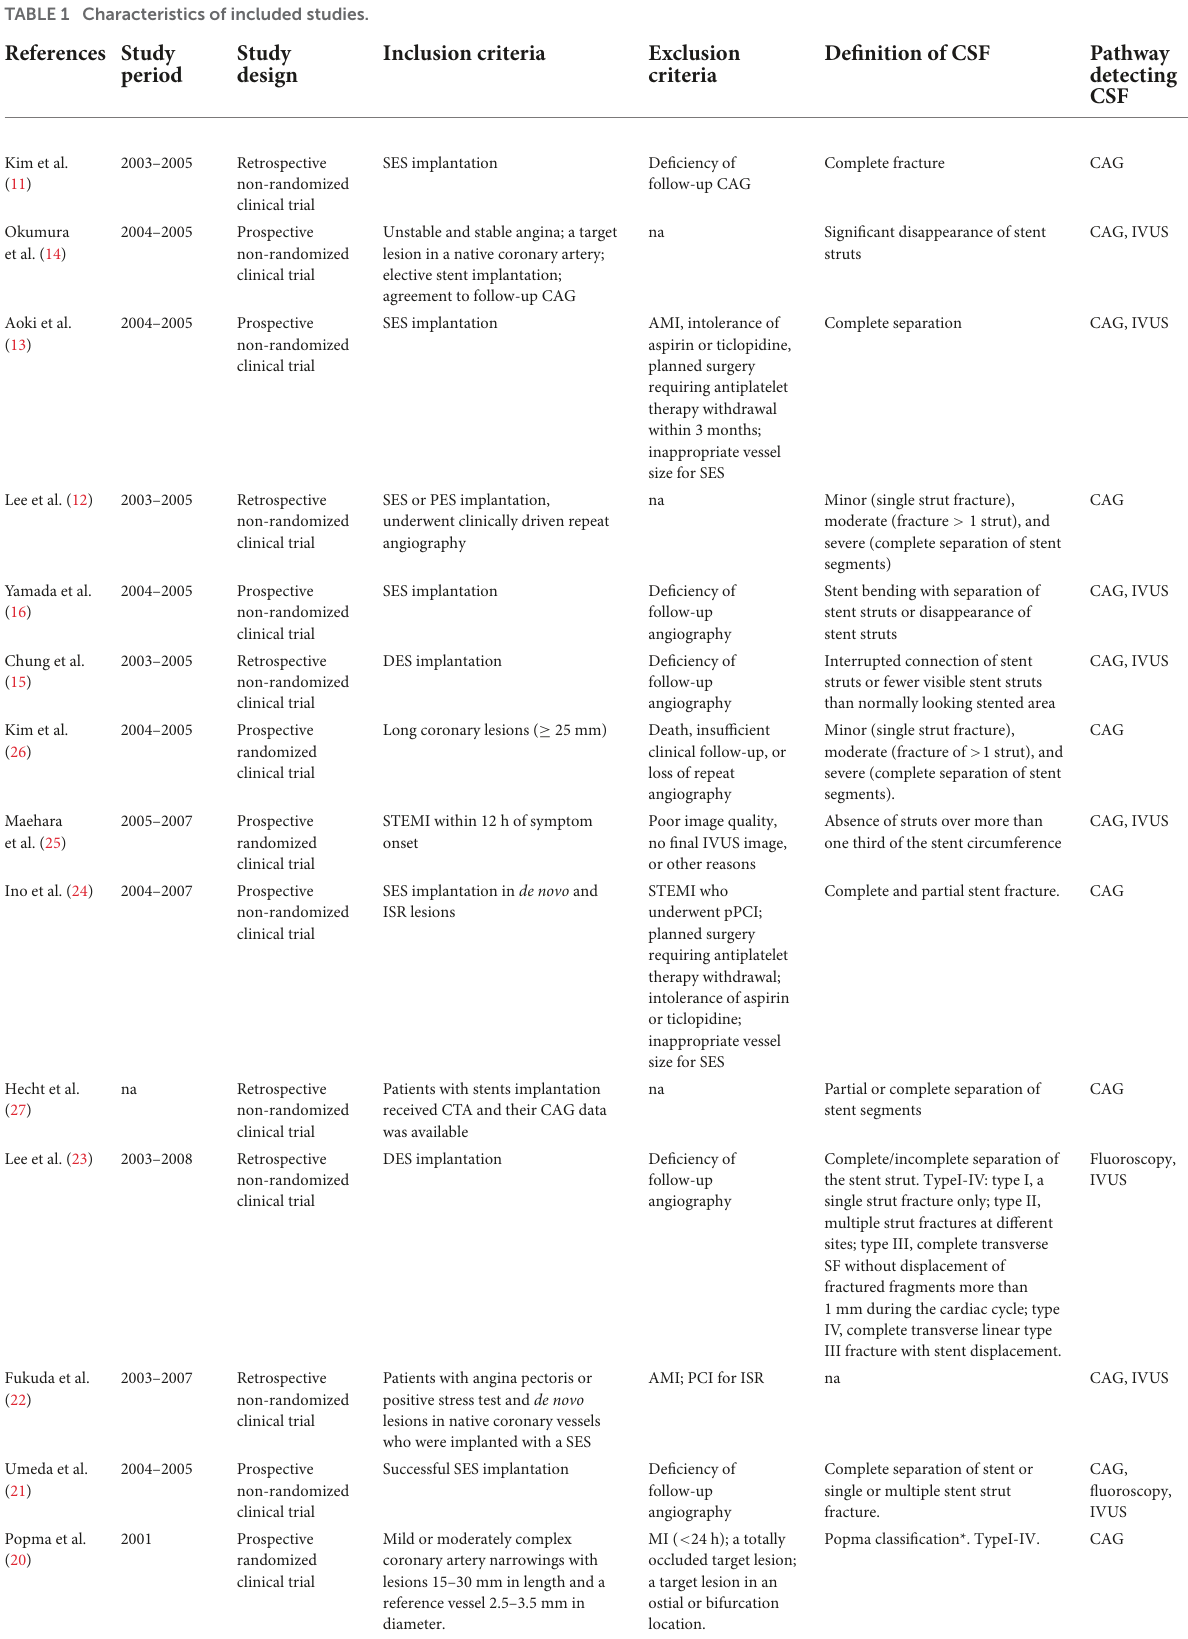
TABLE 1 Characteristics of included